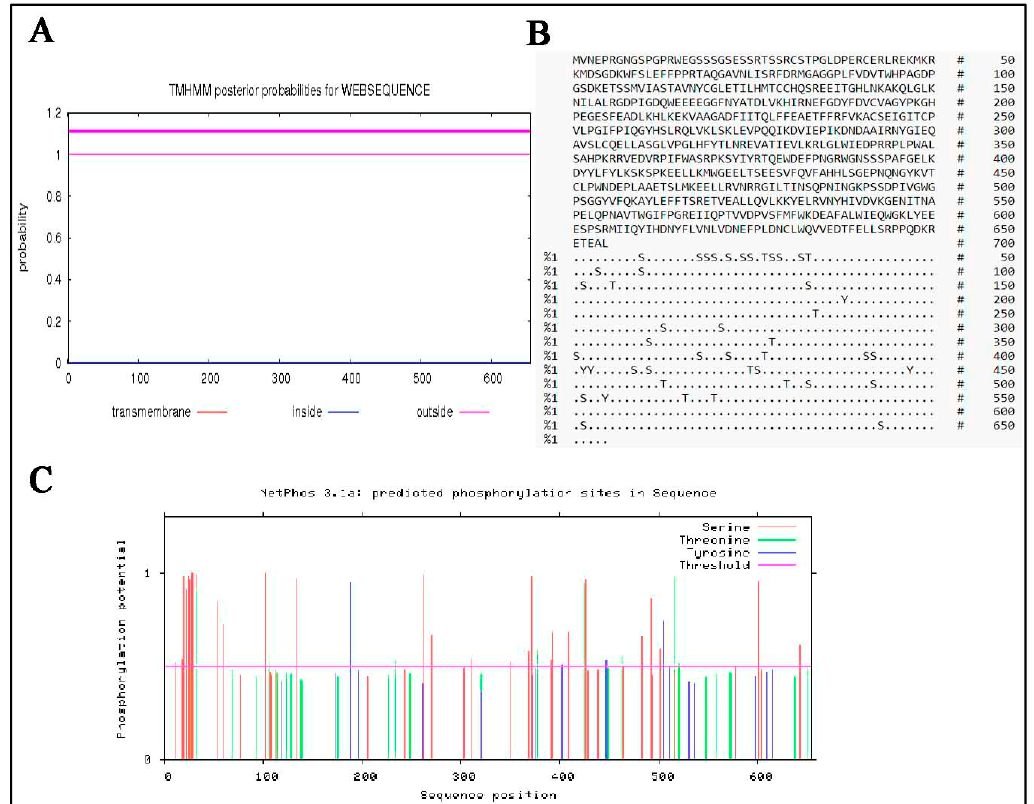
Figure 5. ( A ) Determination of transmembrane characteristics of yellow-cattle MTHFR, and ( B , C ) Phosphorylation sites in yellow-cattle MTHFR protein sequence.